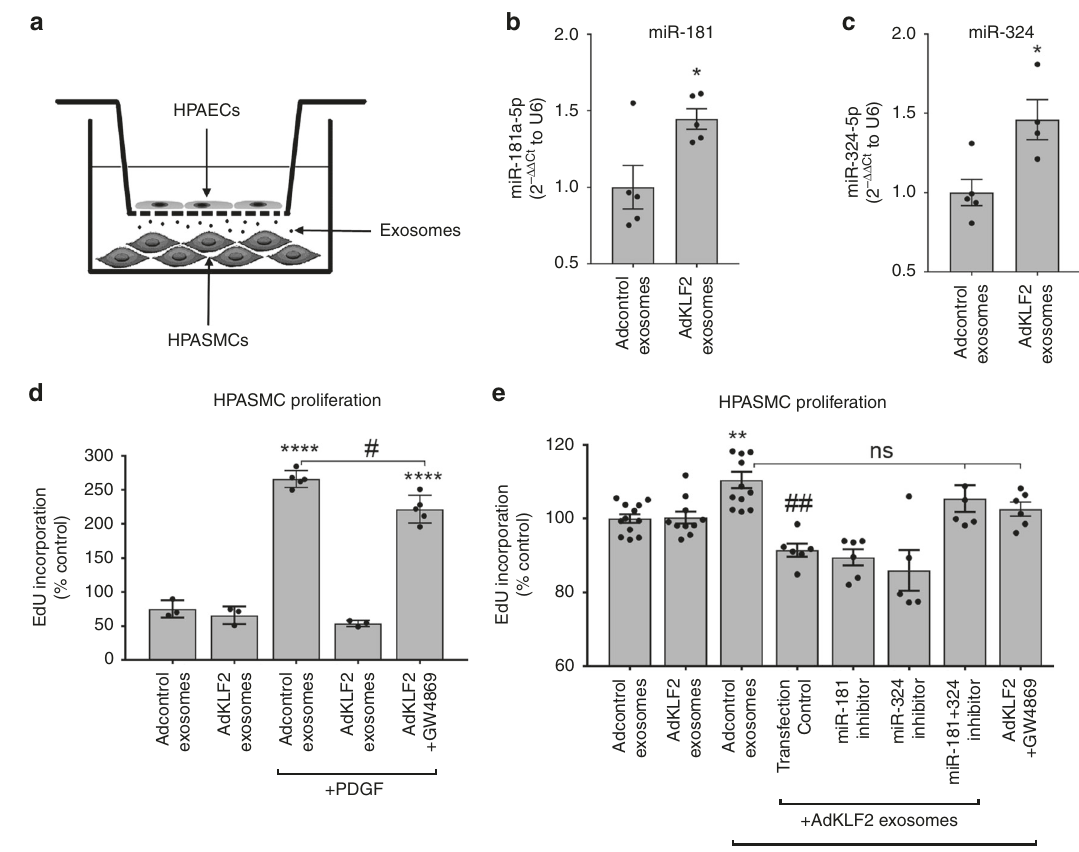
Fig. 4 The effect of endothelial KLF2 on smooth muscle cell proliferation. a Transwell dish with KLF2-overexpressing HPAECs separated from HPASMCs by a porous (0.4 µ m pore size) membrane. b , c miR-181 and miR-324 levels in HPASMCs co-cultured with Adcontrol and AdKLF2-overexpressing HPAECs for 24 h. The effect of endothelial KLF2 exosomes on d PDGF (10 ng/mL, 48 h) and e hypoxia-induced HPASMC proliferation. HPAECs pre-treated with exosome inhibitor GW4869 (10 µ M) were used as a negative control. In d , e , bars show the percentage of untreated, untransfected controls; * P < 0.05, ** P < 0.01, *** P < 0.001, comparison with Adcontrol or exosomes group; ### P < 0.001, comparison with Adcontrol + exosomes, hypoxia group; # P < 0.05; & P < 0.05, comparisons as indicated. Unpaired t -test ( b , c ) or one-way ANOVA with Tukey post-test ( d , e ). Bars are means± s.e.m. ( b , c ) n = 5, d n = 3 – 5, e n = 5 – 12 of independent experiments. Source data are provided in Source Data fi